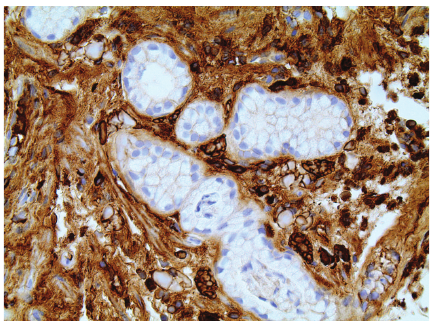
Figure 6: Lambda light chain immunostain, 40x . The Russell body- laden plasma cells show both kappa and lambda (i.e., polyclonal) immunoglobulin